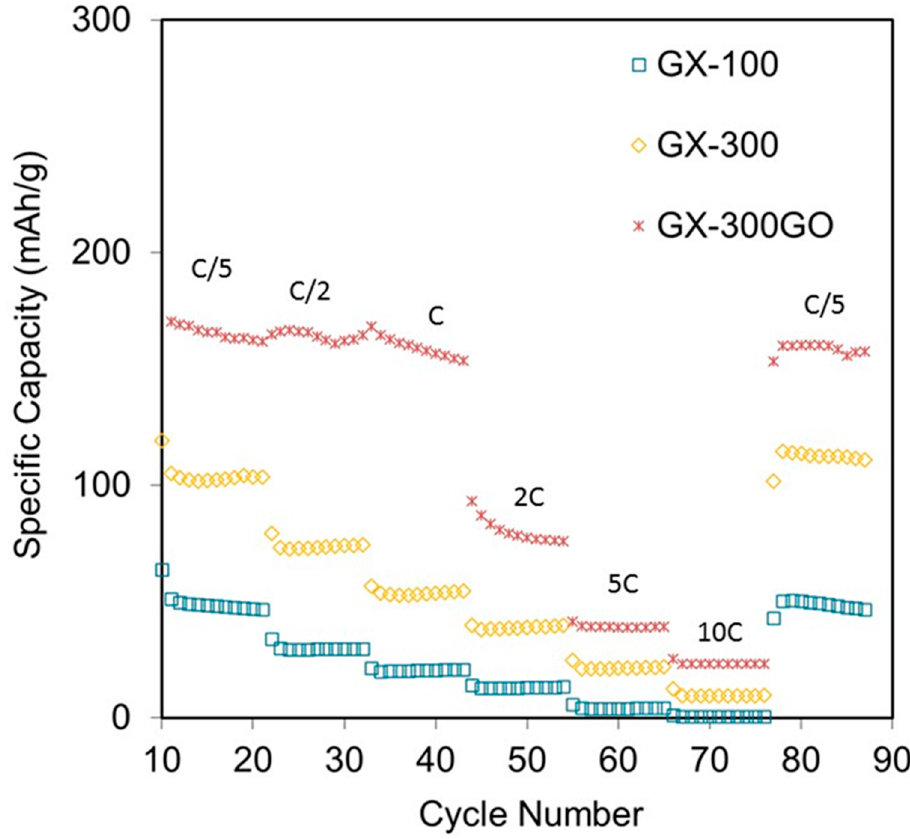
ff erent C-rates for the gels studied.